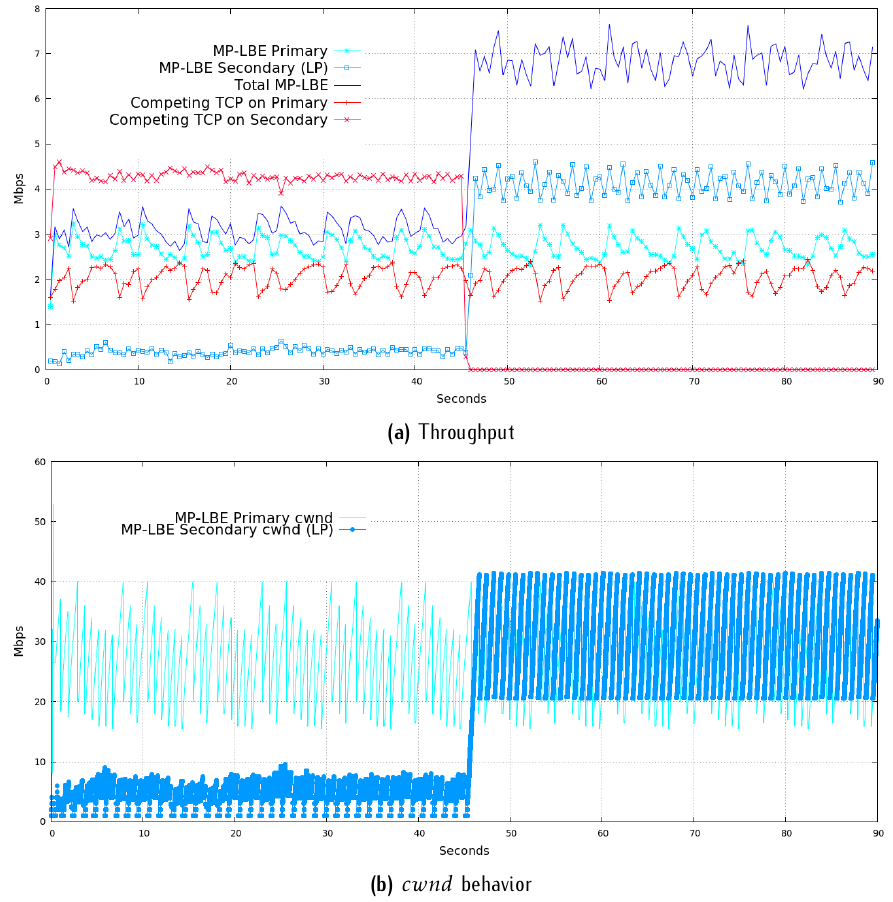
Figure 4. Bandwidth scavenging behavior of MP-LBE using